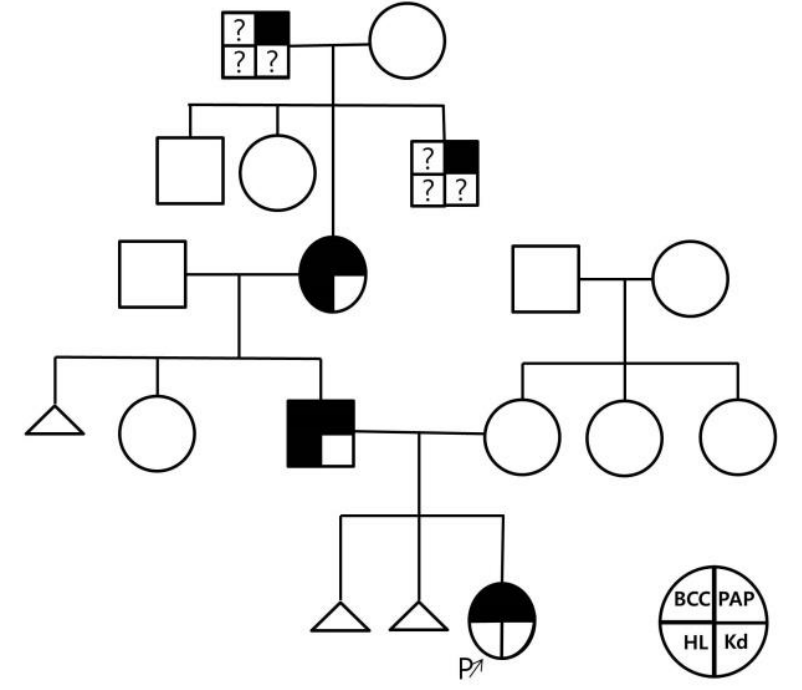
Figure 1. Pedigree of patient with BOR syndrome. BCC: branchial cleft cysts, PAP: preauricular pits, HL: hearing loss, Kd: kidney anomaly, ?: unknown.